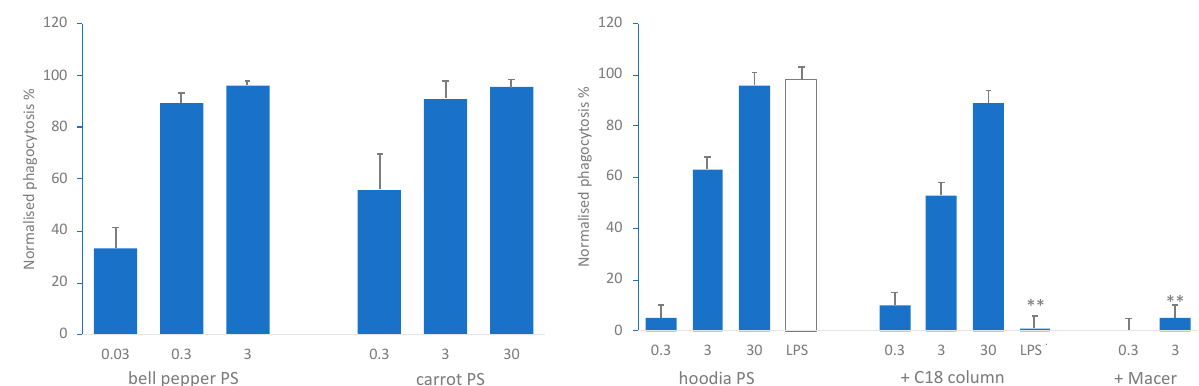
Figure 1. Left: stimulation by bell pepper-PS and carrot-PS of in vitro phagocytosis of fluorescently labelled E. coli by phagocytic cells from human blood. Right: stimulation by hoodia PS extracts (and 50 ng/mL LPS as control) before and after passage over C18 column. +Macer indicates effect of hoodia-PS after 24 h incubation with Macer-8W enzyme mix. Results are expressed as % of stimulation by positive control (average + SEM of three donors). LPS +C18 column is significantly different from LPS, and 3 µg/mL hoodia PS + Macer from the same concentration without Macer, (** p < 0.01).